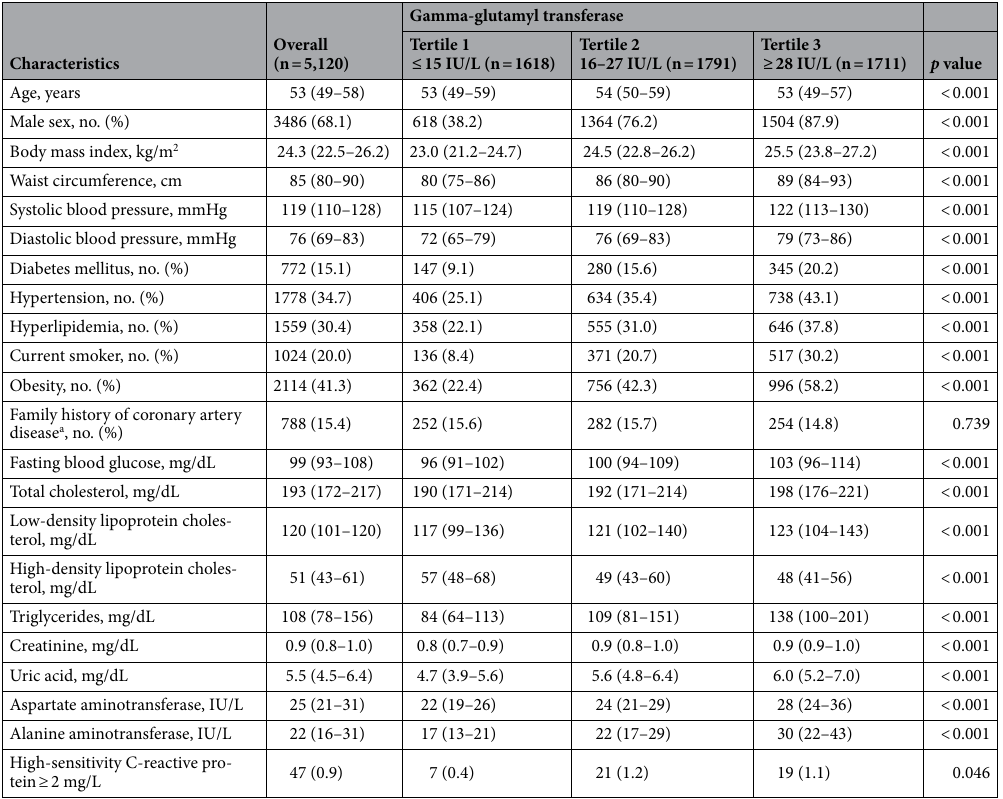
Table 1. Baseline characteristics of the study population according to the tertiles of gamma-glutamyl transferase. Values are presented as median (interquartile range) or number (%). Pearson’s chi-square test or Fisher’s exact test were used for categorical variables and one-way analysis of variance or Kruskal–Wallis test were used for numerical variables. a Coronary artery disease in a first-degree relative of any